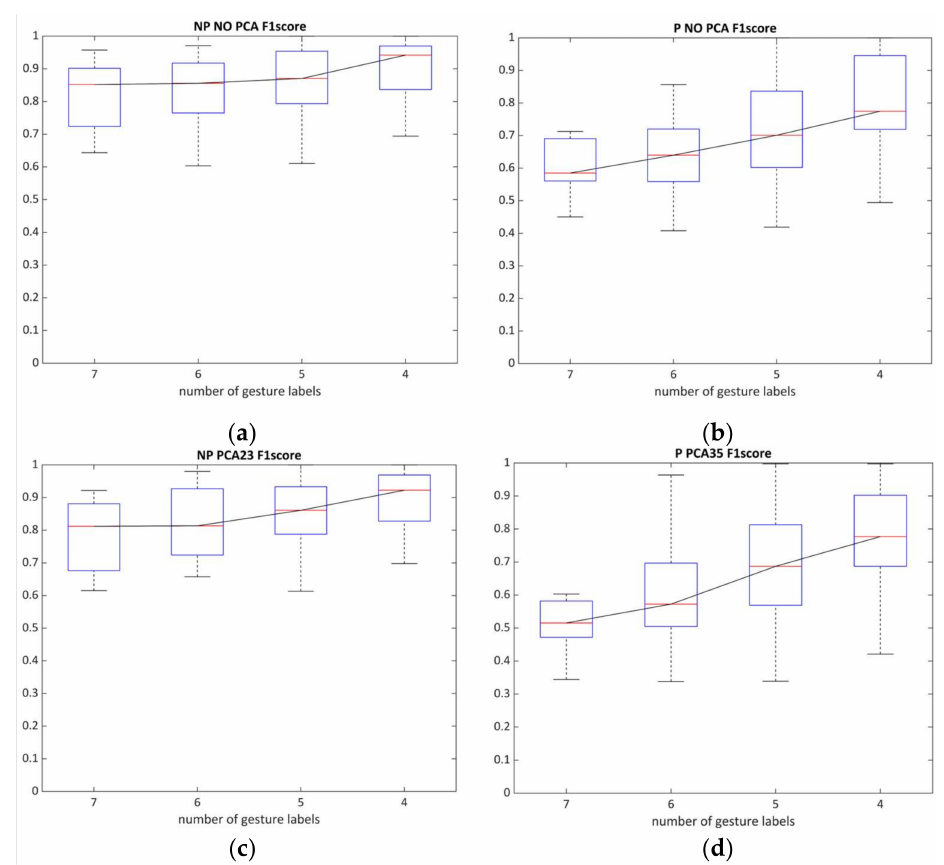
Figure 10. The relationship between the number of gestures and the average value of the F 1 -score (cross-validated by SVM with and without PCA for paretic and non-paretic datasets): ( a , c ) NP19 without and with the use of PCA; ( b , d ) P19 with and without the use of